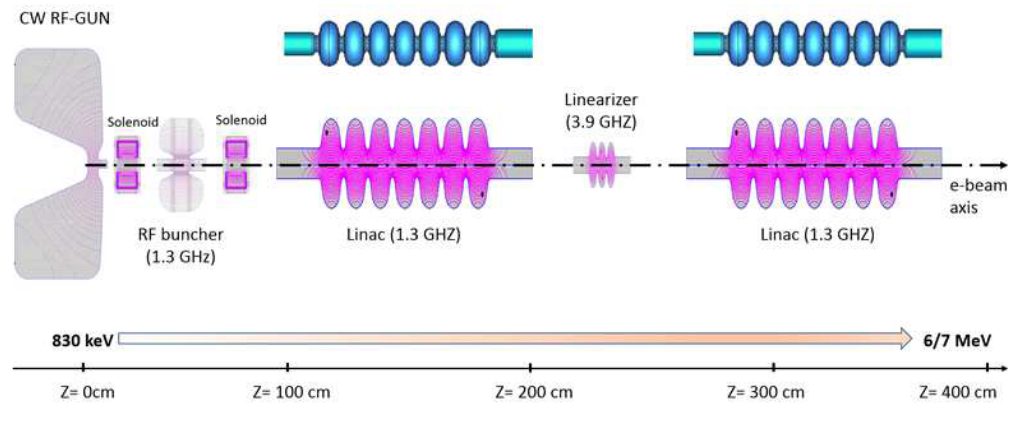
Figure 2. Injector layout for 1 beam-line, SuperFish 2D